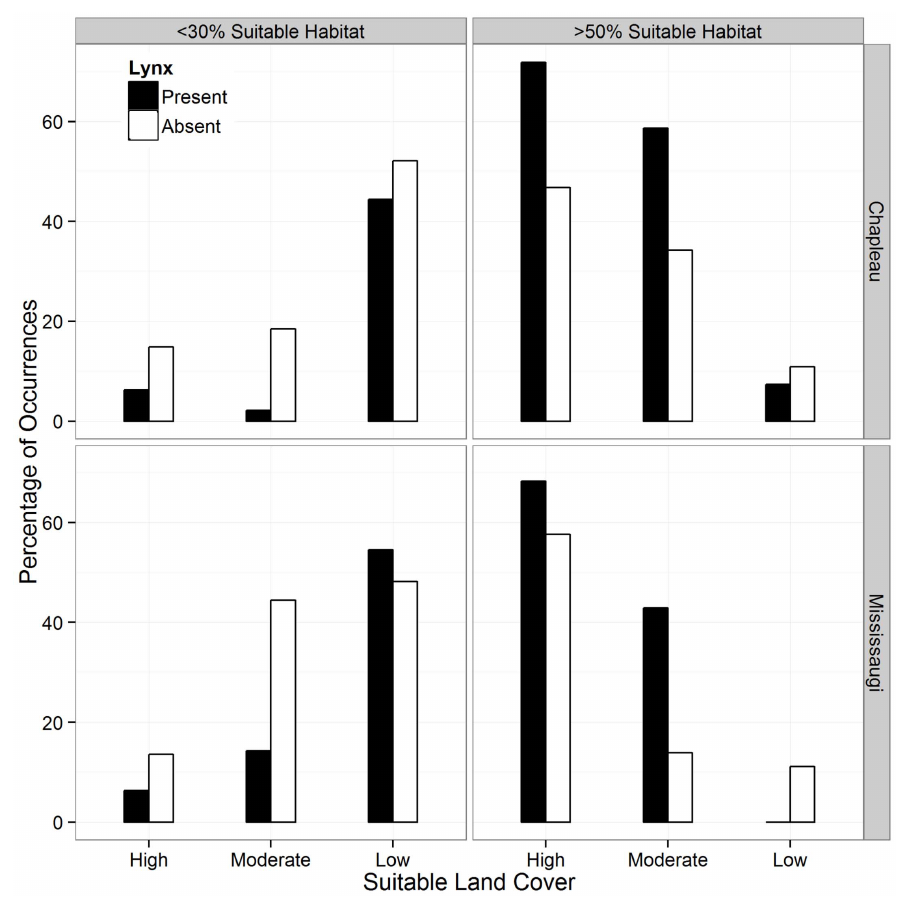
Figure 3. Distribution of lynx occurrences and pseudo-absences in relation to the amount of suitable habitat at the 25 km 2 scale in the regions of Chapleau and Mississagi with three levels of suitable land cover.